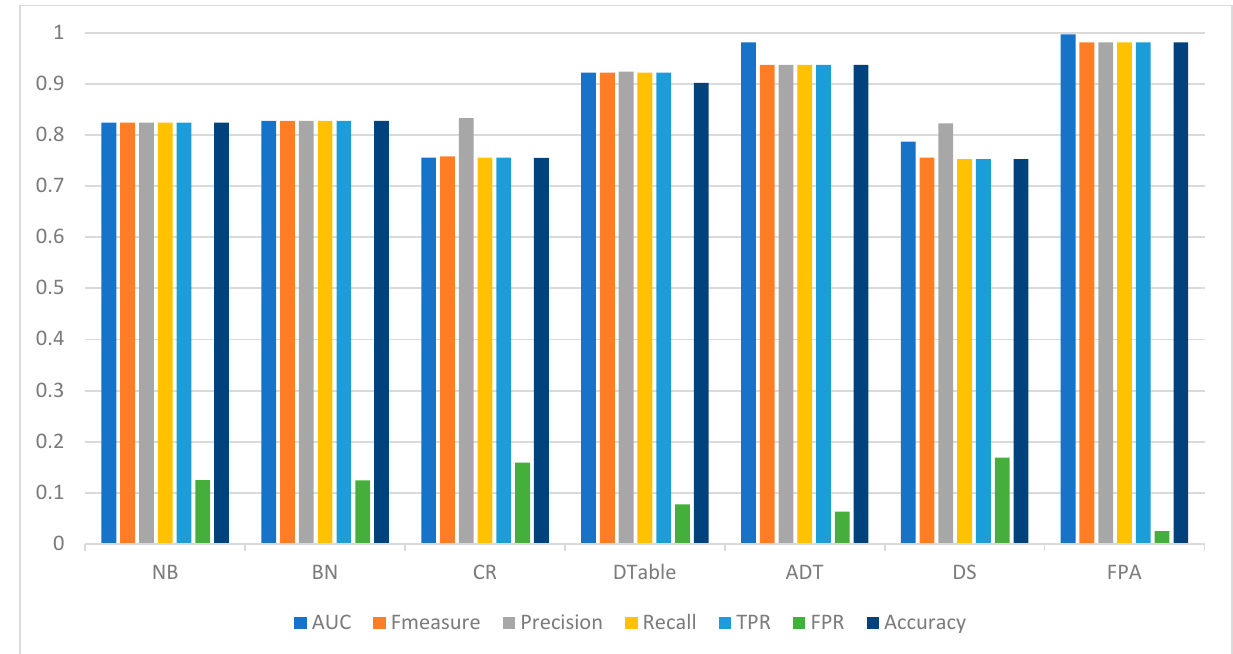
Figure 3. Android malware detection performance of FPA and baseline classifiers on the Drebin dataset.